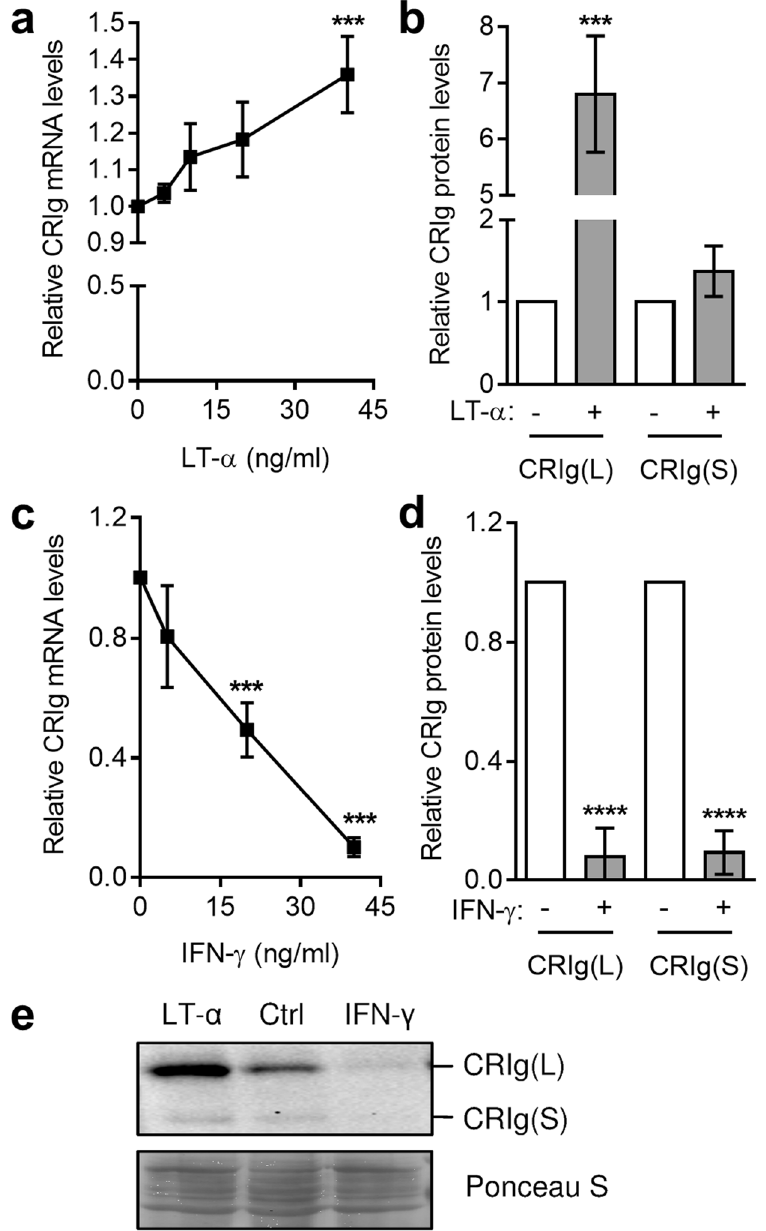
Figure 1. The development of CRIg + macrophages is differentially modulated by LT- α and IFN- γ . Monocytes were cultured in the presence of 0, 5, 10, 20, and 40 ng/ml LT- α ( a ) or 0, 10, 20, and 40 ng/ml IFN- γ ( c ) for 3 days and then CRIg mRNA expression measured. Data are expressed as fold-change over GAPDH-normalised CRIg mRNA in the absence of cytokine set as 1. For CRIg protein expression monocytes were treated with 40 ng/ml LT- α ( b , e ) or IFN- γ ( d , e ) for 7 days and then the CRIg protein levels measured. Note both the Long and Short forms of CRIg are expressed. ( e ) A representative Western blot of total protein lysates is shown with Ponceau S staining showing consistency of protein load. Data are expressed as fold-difference in CRIg band intensity as determined by densitometry with CRIg expression in the absence of cytokine set as 1. Data are presented as means ± SD of three experiments each conducted with cells from three different individuals. *** p < 0.001, **** p <